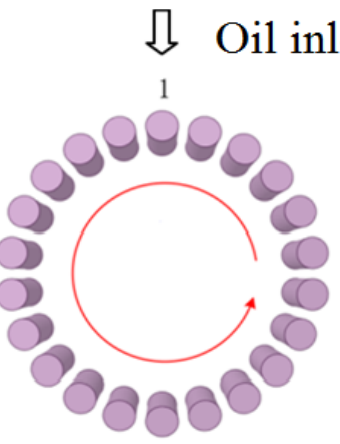
Figure 12. Schematic diagram of roller numbers.